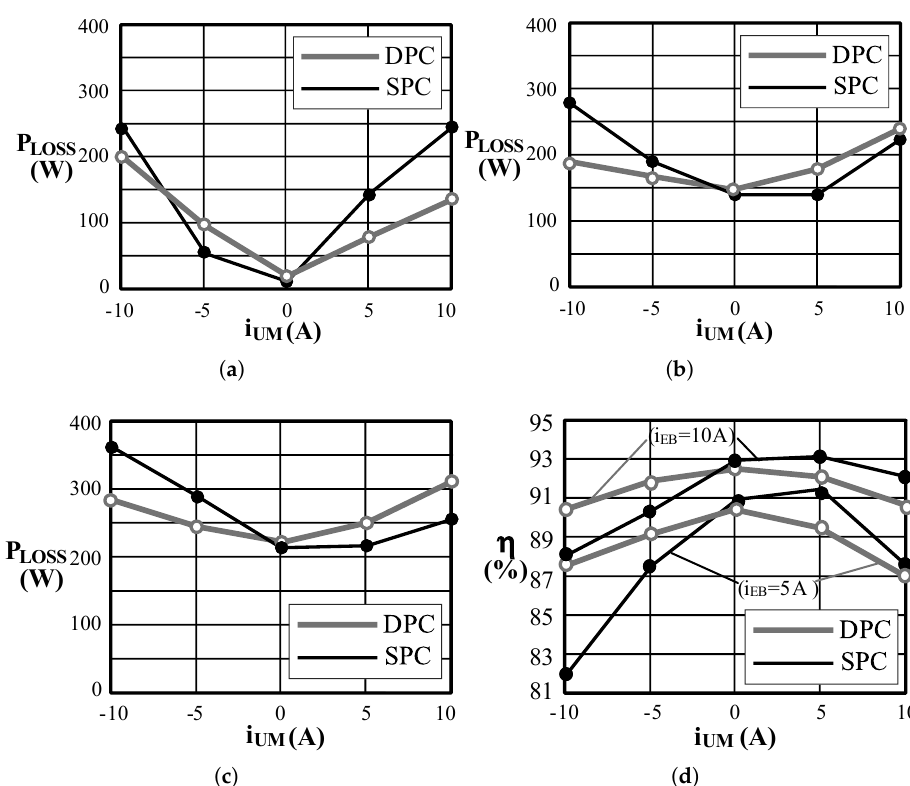
Figure 11. Steady state losses comparison between DPC and SPC configurations: ( a ) i EB = 0 A; ( b ) i EB = 5 A; and ( c ) i EB = 10 A. ( d ) Efficiency measurements of the DPC and SPC schemes, for i EB = 5 A and i EB = 10